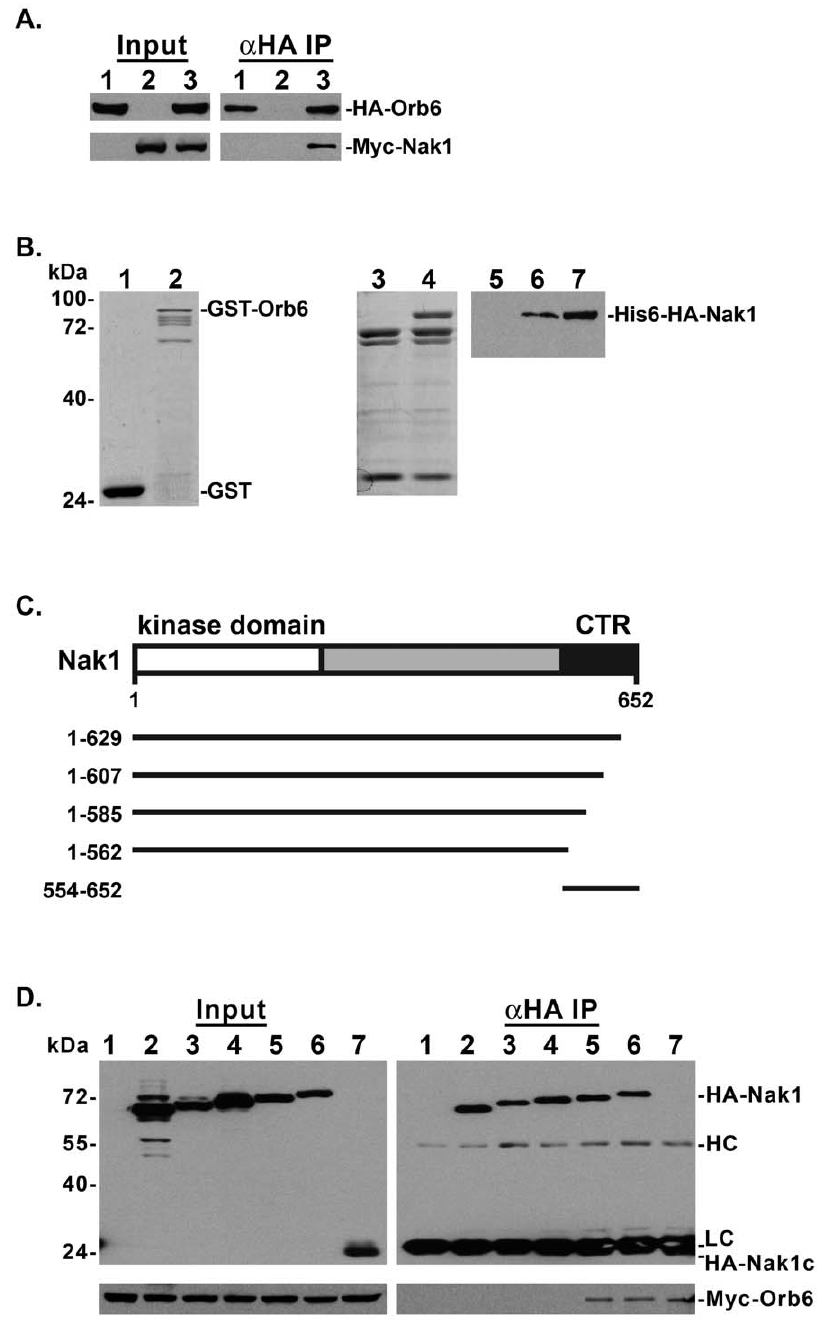
Figure 3. Nak1 and Orb6 interact invitro and invivo . A. Extracts from WT (SP199) cells expressing HA-Orb6 and control vector (lane 1), Myc- Nak1 and control vector (lane 2), or HA-Orb6 and Myc-Nak1 (lane 3) from nmt1 promoter expression plasmids were analyzed by western-blots using anti-Myc (9E10) or anti-HA (12CA5) monoclonal antibodies (Input panels). HA-Orb6 was immunoprecipitated from cell extracts with anti-HA antibody and equal portions of the immunoprecipitates were probed with anti-HA antibody and anti-Myc antibody ( a HA IP panels). B. Interaction of purified recombinant GST-Orb6 and His 6 -HA-Nak1 was assayed by an in vitro binding assay (Materials and Methods). The left panel shows Coomassie blue staining of purified recombinant GST (lane 1), GST-Orb6 (lane 2), His 6 -vector control (lane 3), His 6 -HA-Nak1 (lane 4). Purified His 6 -HA-Nak1 (input, lane 7) was incubated with either GST (lane 5) or GST-Orb6 (lane 6) bound to Glutathione Sepharose 4B beads. The right panel shows a Western blot using anti-HA (12CA5) antibody of His 6 -HA-Nak1 bound to the beads. C. Schematic diagram of mutant Nak1 expression constructs. The Nak1 N- terminal kinase domain (residues 1–262) and C-terminal (CTR) region (554–652) are indicated. The numbers at the left and the bars at the right indicate the region of Nak1 encoded by the various deletion constructs. D. Extracts from wild-type (SP199) cells co-expressing Myc-Orb6 with the control vector (lane 1), HA-Nak1 1–562 (lane 2), HA-Nak1 1–585 (lane 3), HA-Nak1 1–607 (lane 4), HA-Nak1 1–629 (lane 5), HA-Nak1 (lane6), or HA-Nak1 554–652 (lane 7) were analyzed by western-blots using anti-Myc (9E10) or anti-HA (12CA5) monoclonal antibodies (Input panels). Extracts were immunoprecipitated with anti-HA antibody and equal portions of the immunoprecipitates were probed with anti-HA antibody and anti-Myc antibody ( a HA IP panels).